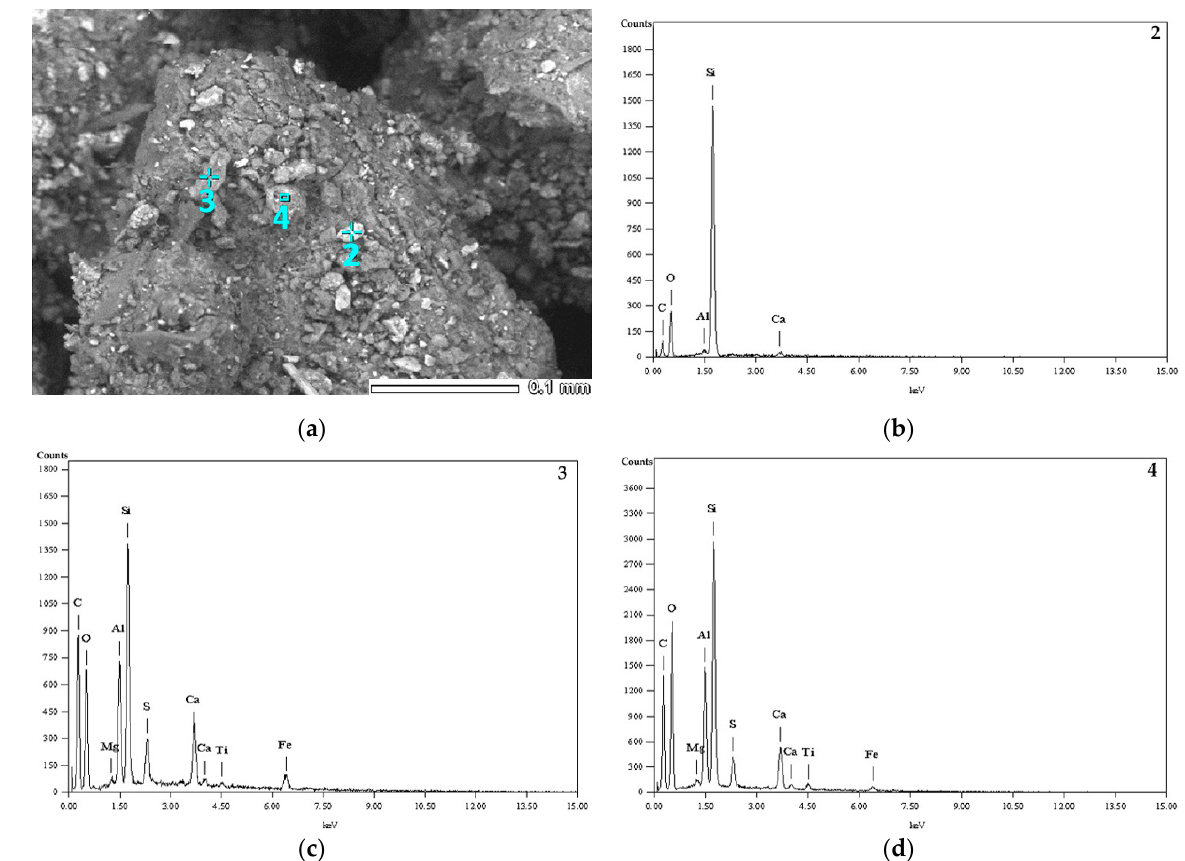
Figure 2. Dispersion energy spectrum of X-rays (EDS) for certain area (1) of brown coal, ( a ) photo of analyzed sample of brown coal; ( b ) spectrum.